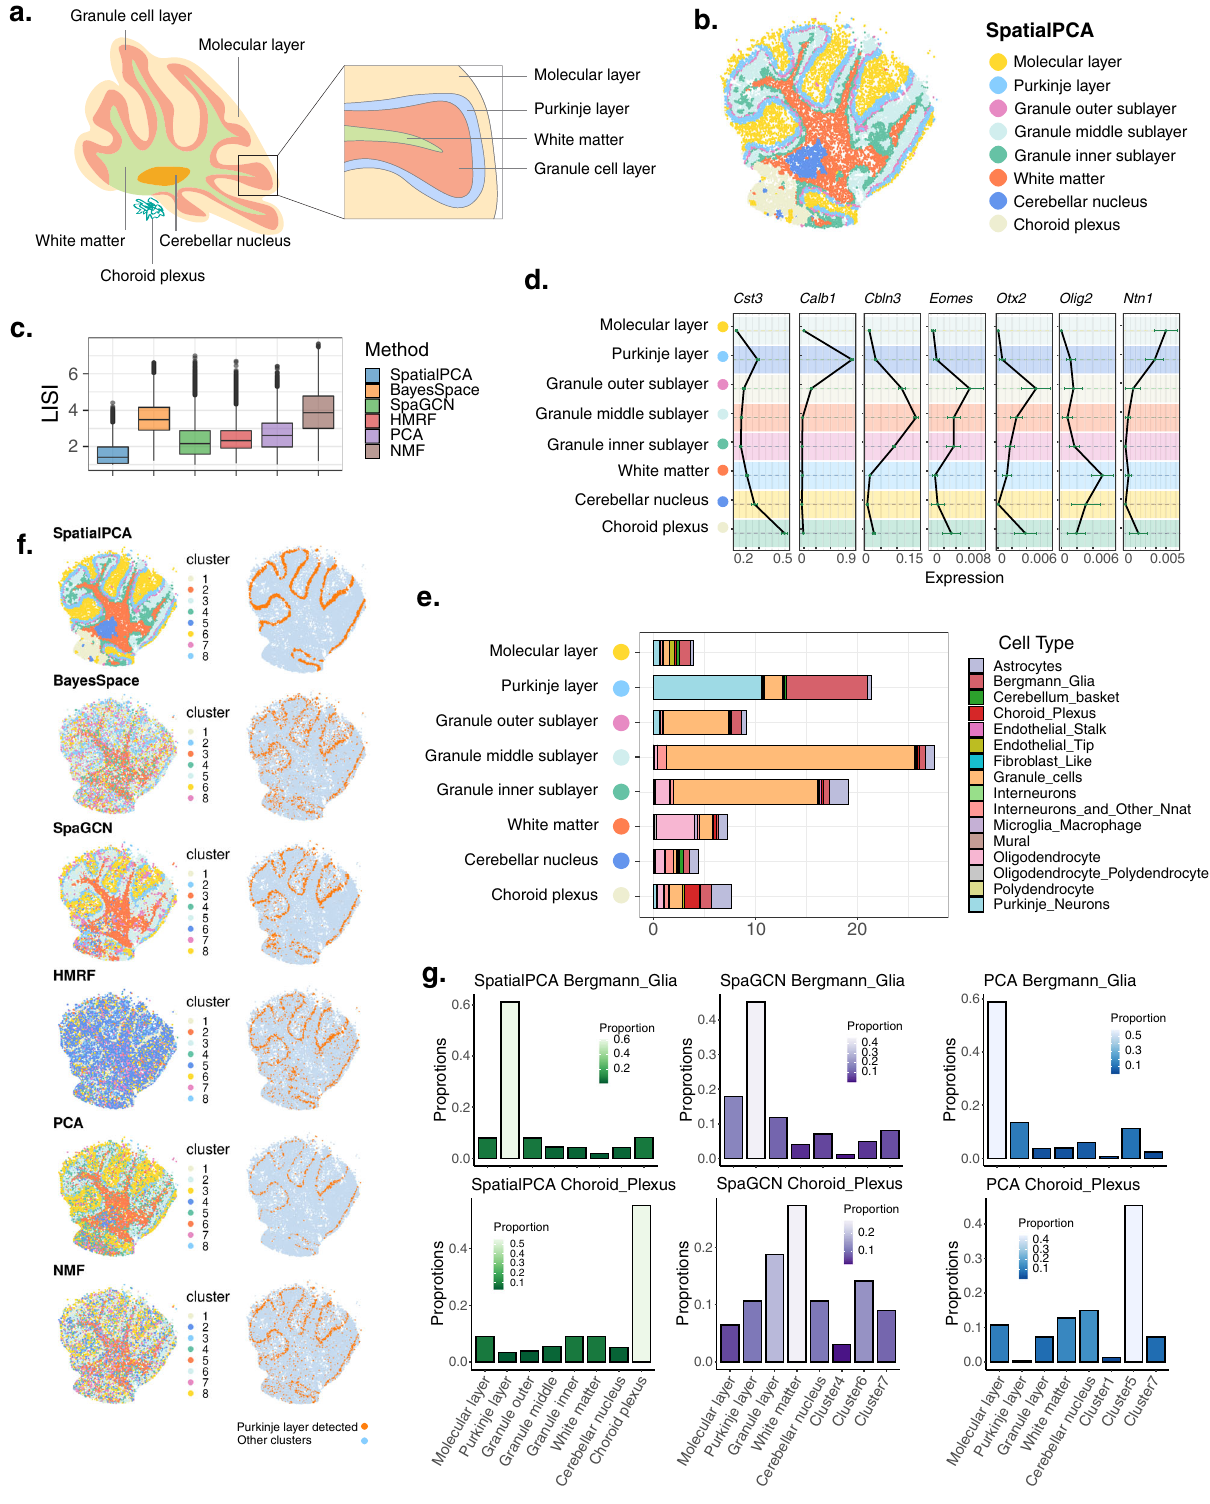
born in the ventricular zone, migrate along the radial glia fi bers in a vertical fashion towards the marginal zone on the outskirt of the cor- tex, and pass the old neurons in the existing layers to form the new cortical layers 39,40 . In contrast, the trajectories inferred based on the low-dimensional components of PCA and NMF point towards almost random directions on the tissue (Supplementary Fig. 15b, c). We also performed trajectory inference using stLearn, which detected multiple